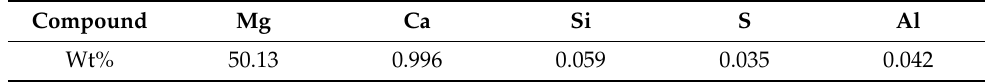
Table 3. Chemical composition (%) of MgCO 3 · 3H 2 O as analyzed by